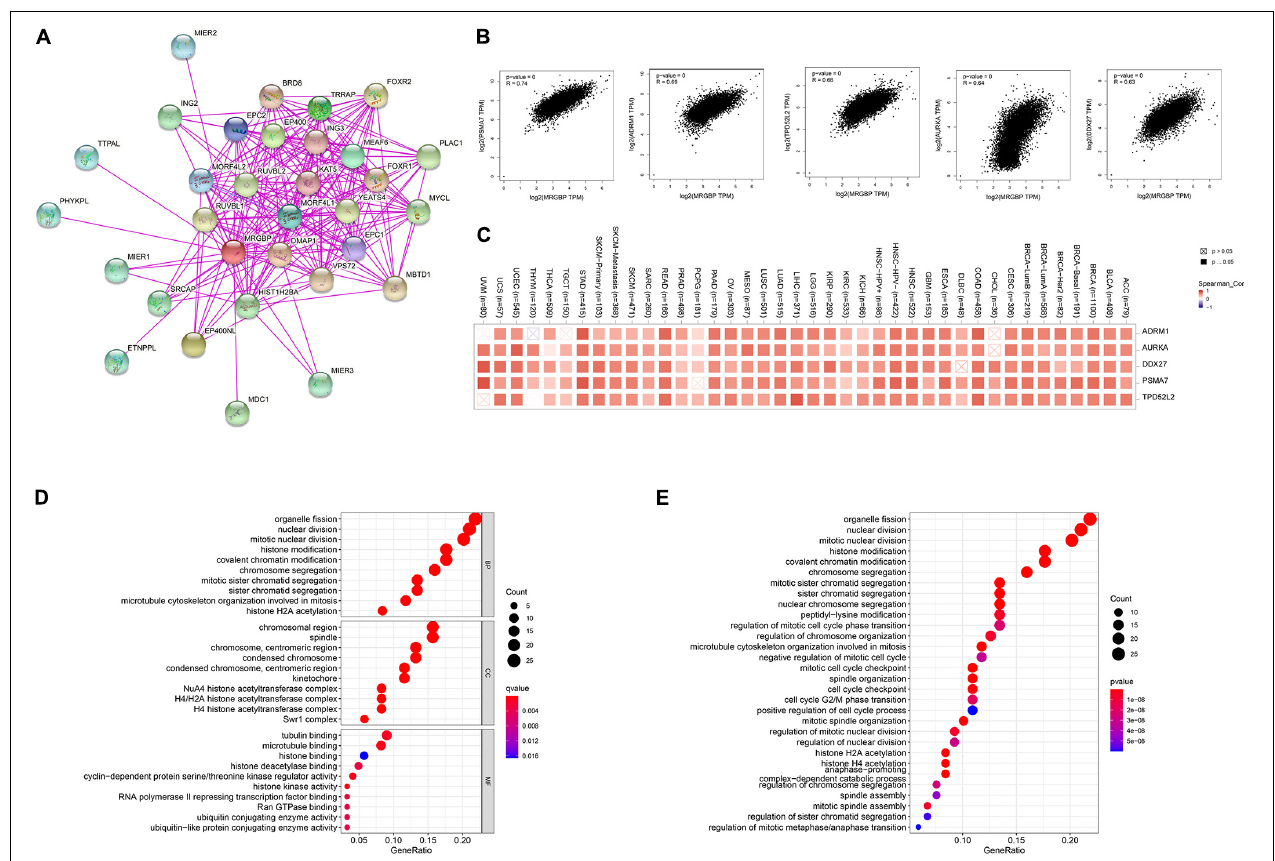
FIGURE 11 | Enrichment analysis of MRGBP-related partners. (A) The PPI network of MRGBP is constructed by STRING database. (B) Correlation analysis between MRGBP and main interacting genes in TCGA using GEPIA2 tool. (C) Corresponding heatmap between the MRGBP expression and the main interacting genes in 33 cancer types. (D) The barplot and bubble of GO enrichment analysis. (E) The barplot and bubble of KEGG enrichment analysis. KEGG, Kyoto Encyclopedia of Genes and Genomes; GO, Gene Ontology; BP, biological process; CC, cellular component; MF, molecular